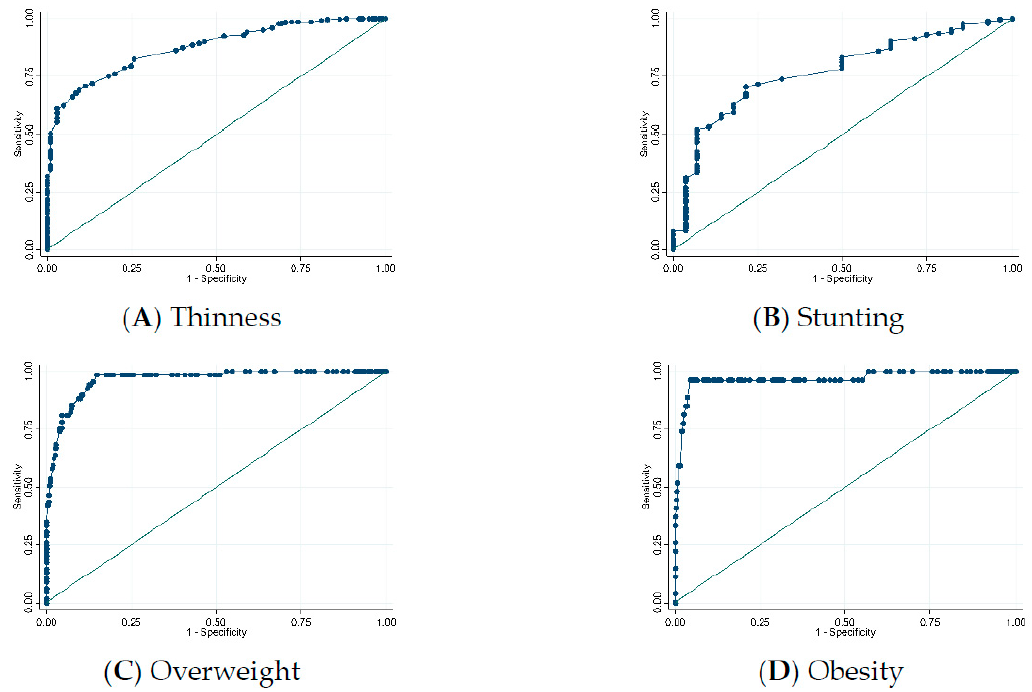
Figure 3. ROC curves for mid-upper arm circumference prediction of: ( A ) Thinness (BAZ < − 2 SD); ( B ) Stunting (HAZ < − 2 SD); ( C ) Overweight (BAZ > +1 SD); and ( D ) Obesity (BAZ > +2 SD). Abbreviations: ROC, receiver operating characteristic; BAZ, body-mass-index-for-age z-score; SD, standard deviation; HAZ, height-for-age z-score.